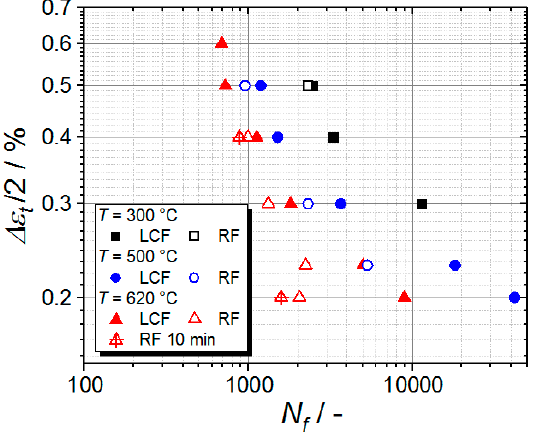
Figure 22. Lifetimes of all LCF- and RF-tests vs. the applied strain amplitude as a function of temperature.